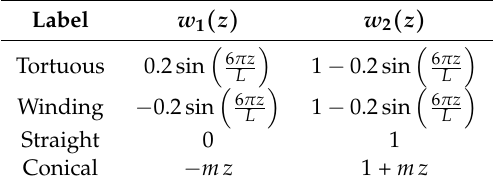
Table A1. Values of the parameters used to build the four pores used in the main text.